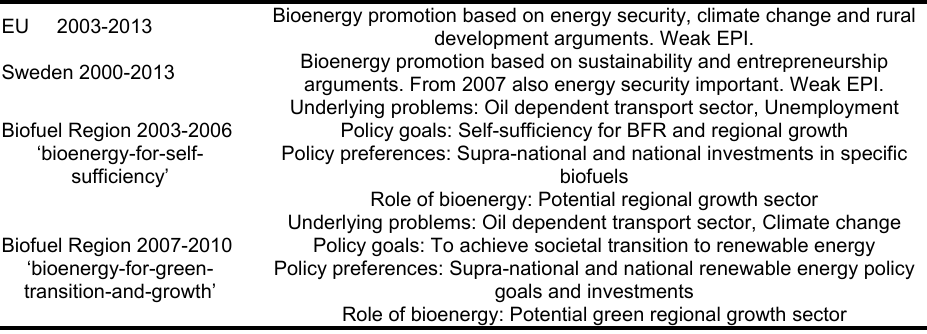
Table 1: Framing of bioenergy: a cross-level overview Bioenergy promotion based on energy security, climate change and rural EU 2003-2013 development arguments. Weak EPI. Bioenergy promotion based on sustainability and entrepreneurship Sweden 2000-2013 arguments. From 2007 also energy security important. Weak EPI. Underlying problems: Oil dependent transport sector, Unemployment Biofuel Region 2003-2006 Policy goals: Self-sufficiency for BFR and regional growth ‘bioenergy-for-self- Policy preferences: Supra-national and national investments in specific sufficiency’ biofuels Role of bioenergy: Potential regional growth sector Underlying problems: Oil dependent transport sector, Climate change Biofuel Region 2007-2010 Policy goals: To achieve societal transition to renewable energy ‘bioenergy-for-green- Policy preferences: Supra-national and national renewable energy policy transition-and-growth’ goals and investments Role of bioenergy: Potential green regional growth